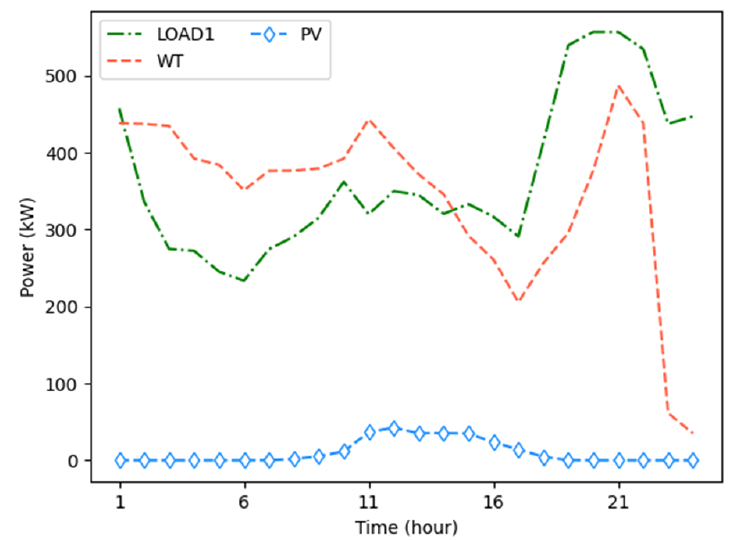
Figure 5. WT, PV output, and load power curve of MG 1.